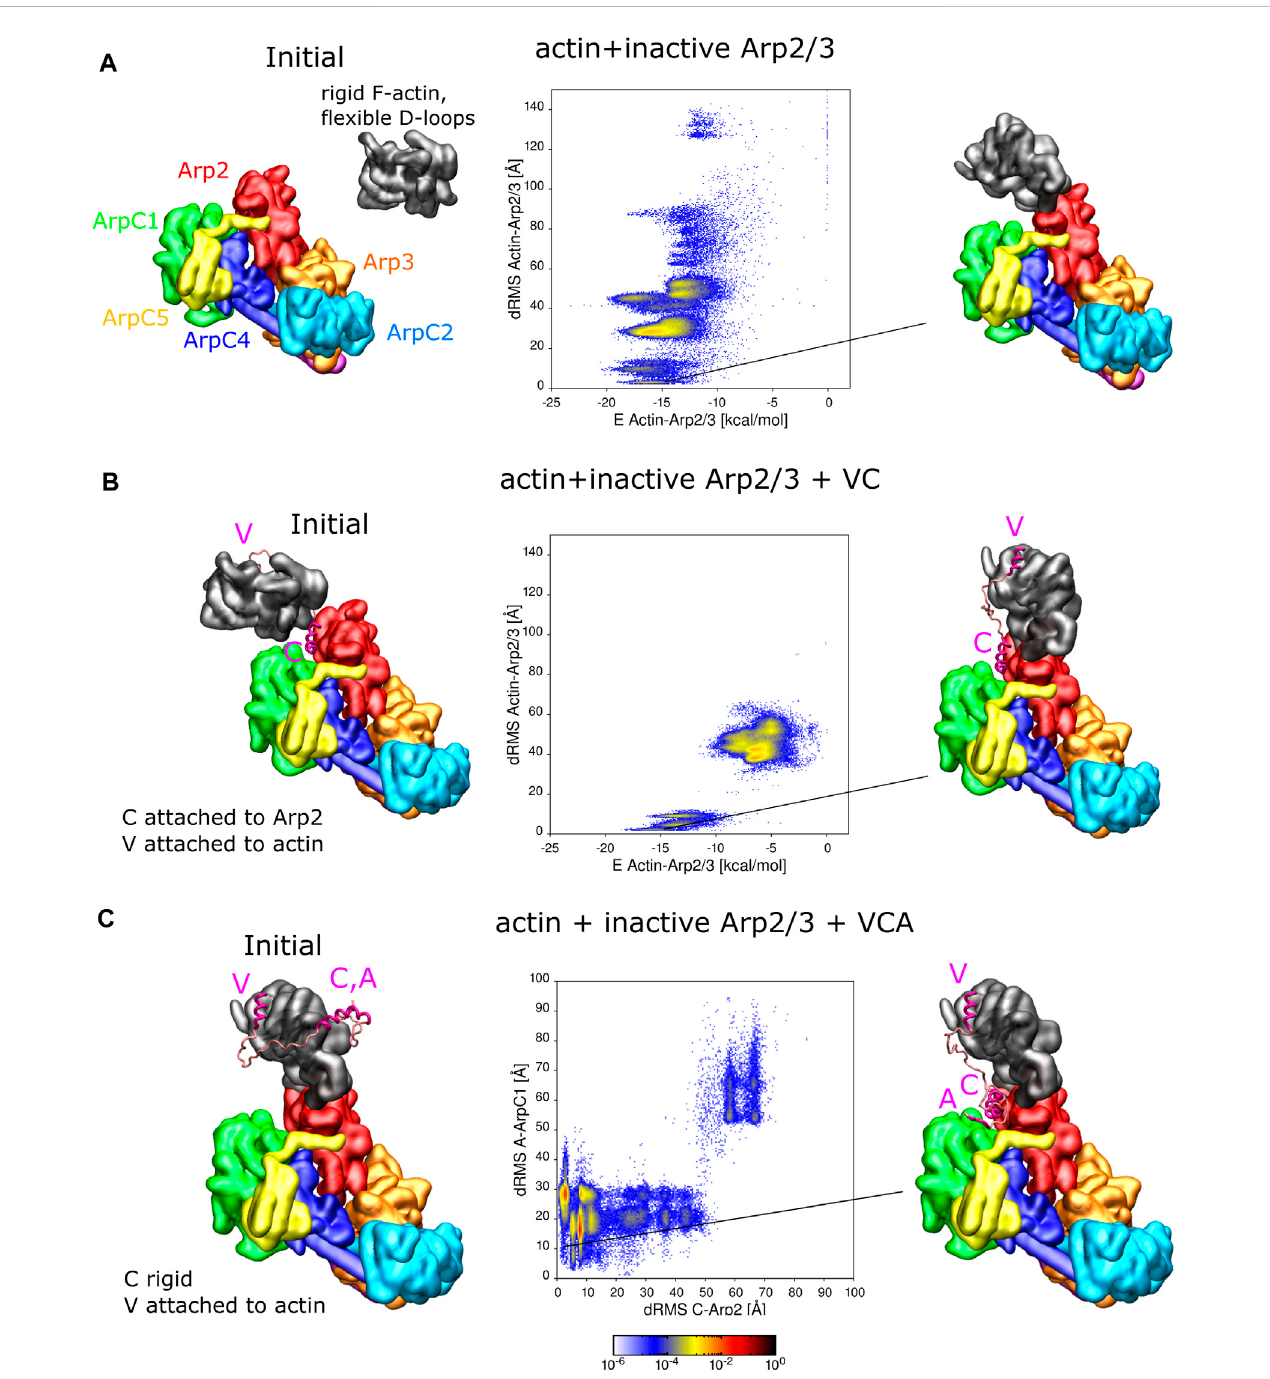
FIGURE 3 Interaction of actin and VCA with inactive Arp2/3 complex. (A) REMD simulations of actin delivery to Arp2 of inactive Arp2/3 complex. The actin monomer is in the rigid F-actin conformation with fl exible D-loop. Left: Initial conformation with actin separated from Arp2/3 complex. Middle: 2D- distributionsof dRMS vs.bindingenergy arecalculatedandplottedin binsof .1 kCal/mol × .5 Å. Right:Exampleof conformationarerandomlyselected from the lowest dRMS hotspot. (B) Same as panel A but when actin and Arp2/3 are connected by the VC domain, with V rigidly attached to actin and C domain rigidly attached to the Arp2-ArpC1 site. (C) REMD simulations of CA binding to Arp2/3 complex with V rigidly fi xed on actin. The actin monomer is kept fi xed in a long pitch con fi guration. The C helix is kept rigid [in same con fi guration as panel (B) ] and allowed to move with the rest of fl exible CA region. Left: Initial conformationwithCA separated from Arp2/3 complex. Middle: 2D dRMS distributionsof A and C relative to their binding sites on ArpC1 and Arp2, respectively, in bins of .5 × .5 Å. Right: Example from indicated location in dRMS plot. The simulations were performed in cubic boxes of side 300 Å for (A) 780 ns, (B) 1.2 μ s, and (C) 1.8 μ